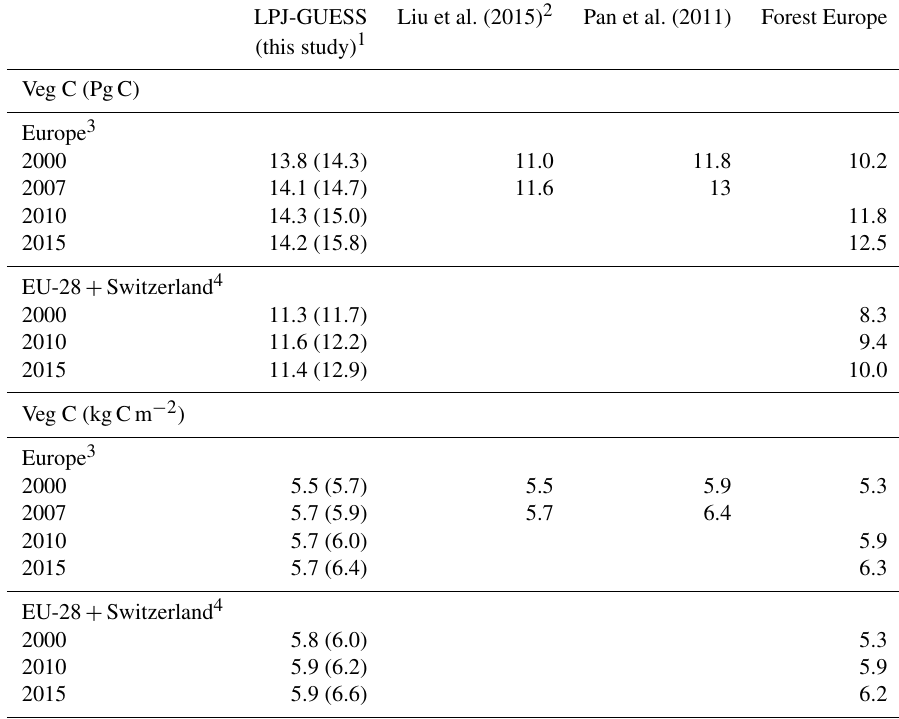
Table 2. Modelled and observed forest vegetation carbon stock in